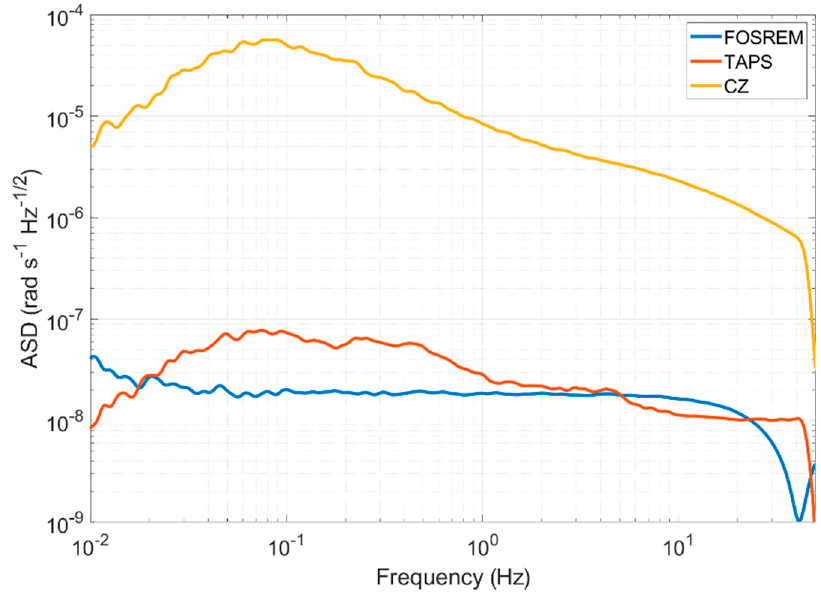
Figure 4. ASDs calculated for all sensors. Table 1. Pearson correlation coefficients between all the